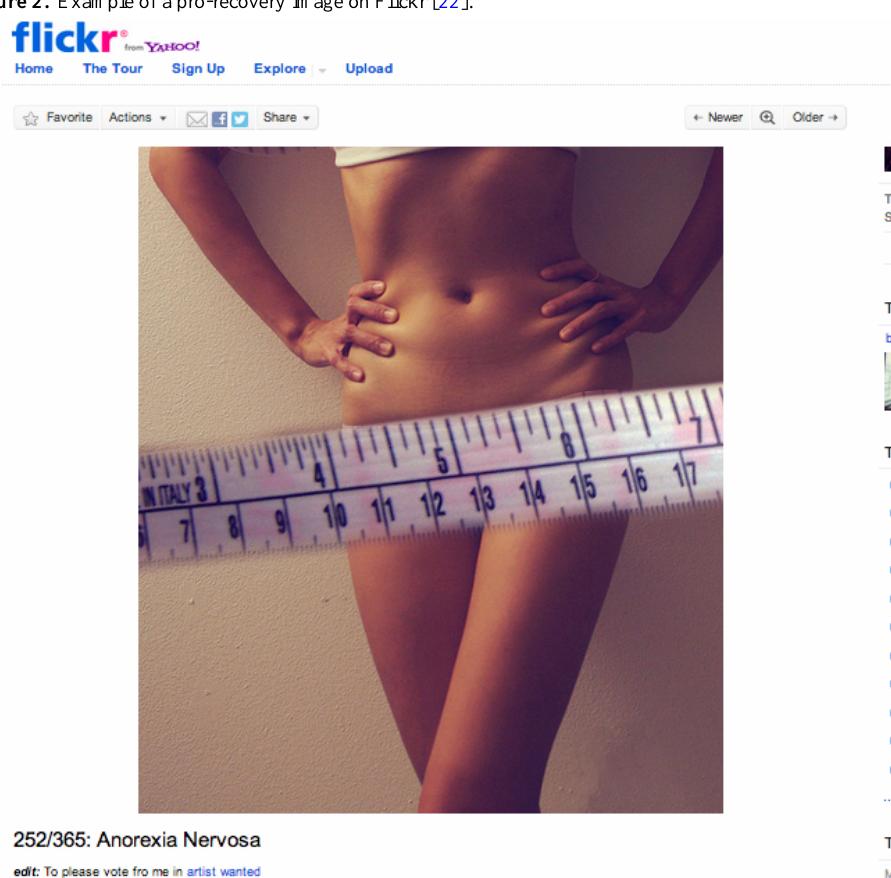
Figure 2. Example of a pro-recovery image on Flickr